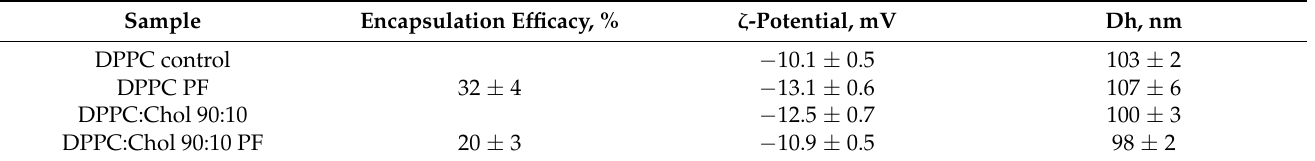
Table 2. Encapsulation efficacy, ζ -potential and hydrodynamic diameter of liposomal form of